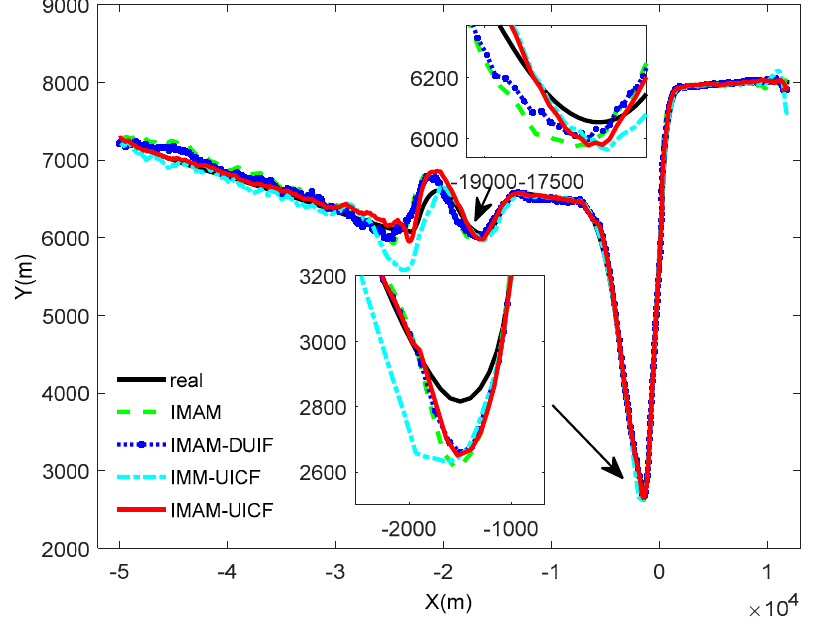
Figure 7. The trajectories of real and the four algorithms.